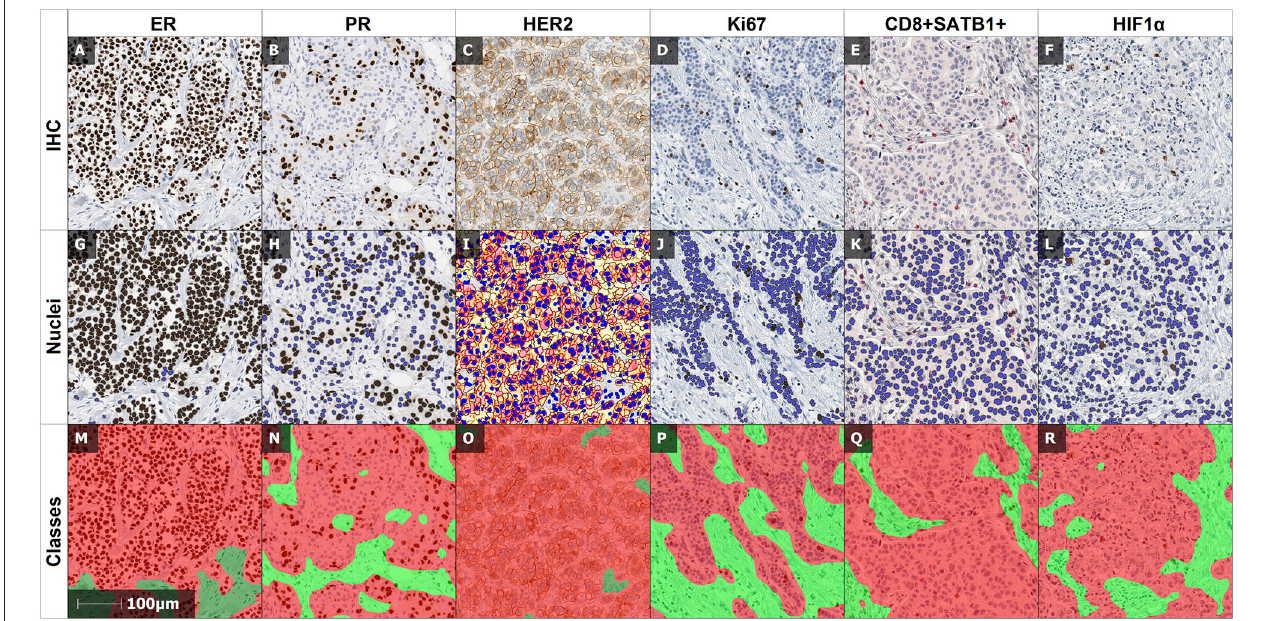
FIGURE 1 | Examples of IHC and DIA output images. (A,G,M) : IHC and corresponding DIA outputs of ER, (B,H,N) of PR, (C,I,O) of HER2, (D,J,P) of Ki67, (E,K,Q) of double IHC of CD8 and SATB1, and (F,L,R) of HIF1 α . The nuclear algorithms mark positive (brown), and negative (blue) cells: (G) of ER, (H) of PR, (J) of Ki67 and cytoplasmic/nuclear algorithm marks positive HIF1 α cells (L) , HER2 algorithm marks the positive cells of HER2 (I) with color masks according to staining intensity (negative—blue, week positive—yellow, moderate positive—orange, intense positive—red). Multiplex algorithm of double IHC (E) separates positive SATB1 (brown), positive CD8 (red) and negative (blue) cells. (M–R) : illustrate the automated detection of the tumor (red) and stroma (green) compartments by the HALO AI tissue